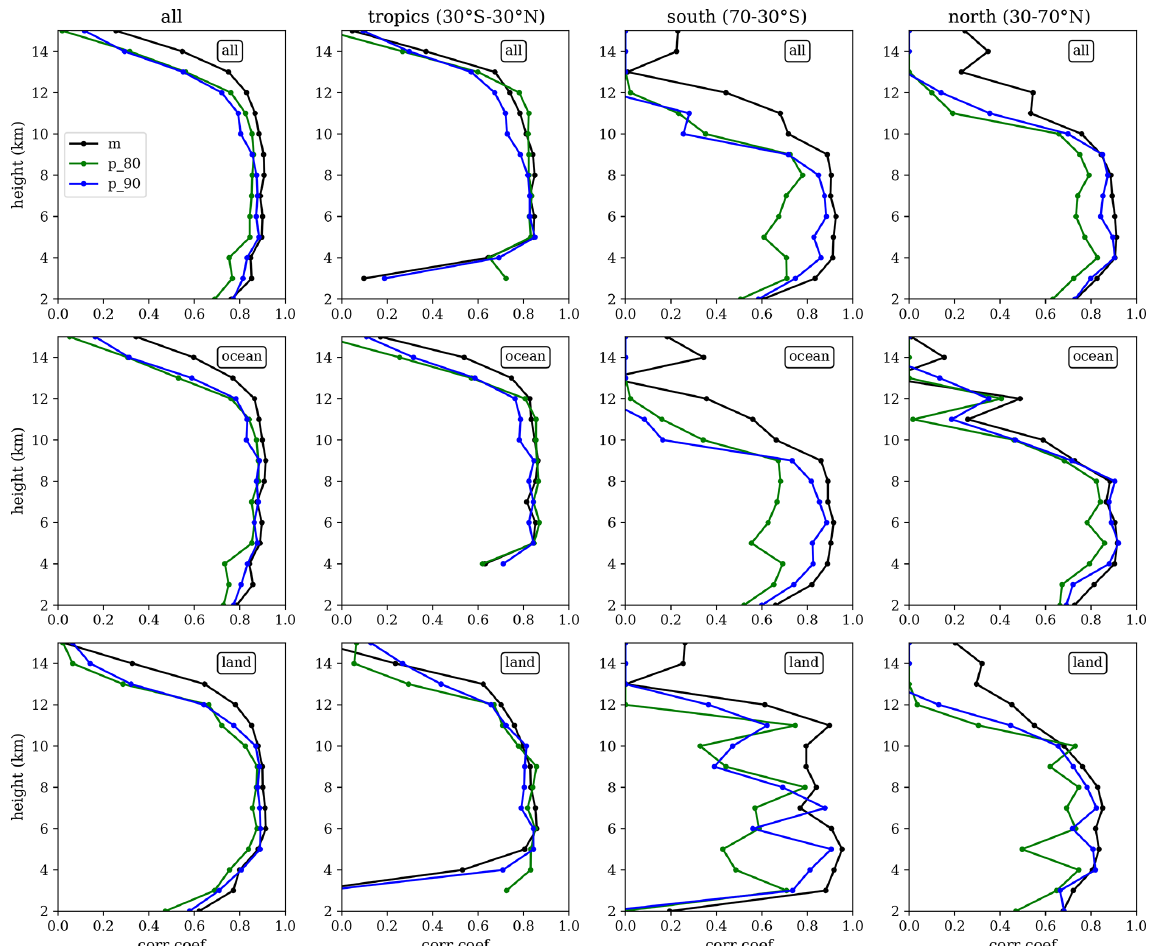
Figure 6. Correlation coefficients between PAZ (cid:49)(cid:56) and CloudSat-RO IWC, as a function of height ( y axis), for different areas across the globe (all globe, tropics, southern extratropics, and northern extratropics) and different surfaces (all, ocean, and land). The black lines correspond to the mean climatologies, the green lines to the 80th percentile, and the blue lines to the 90th percentile climatology.